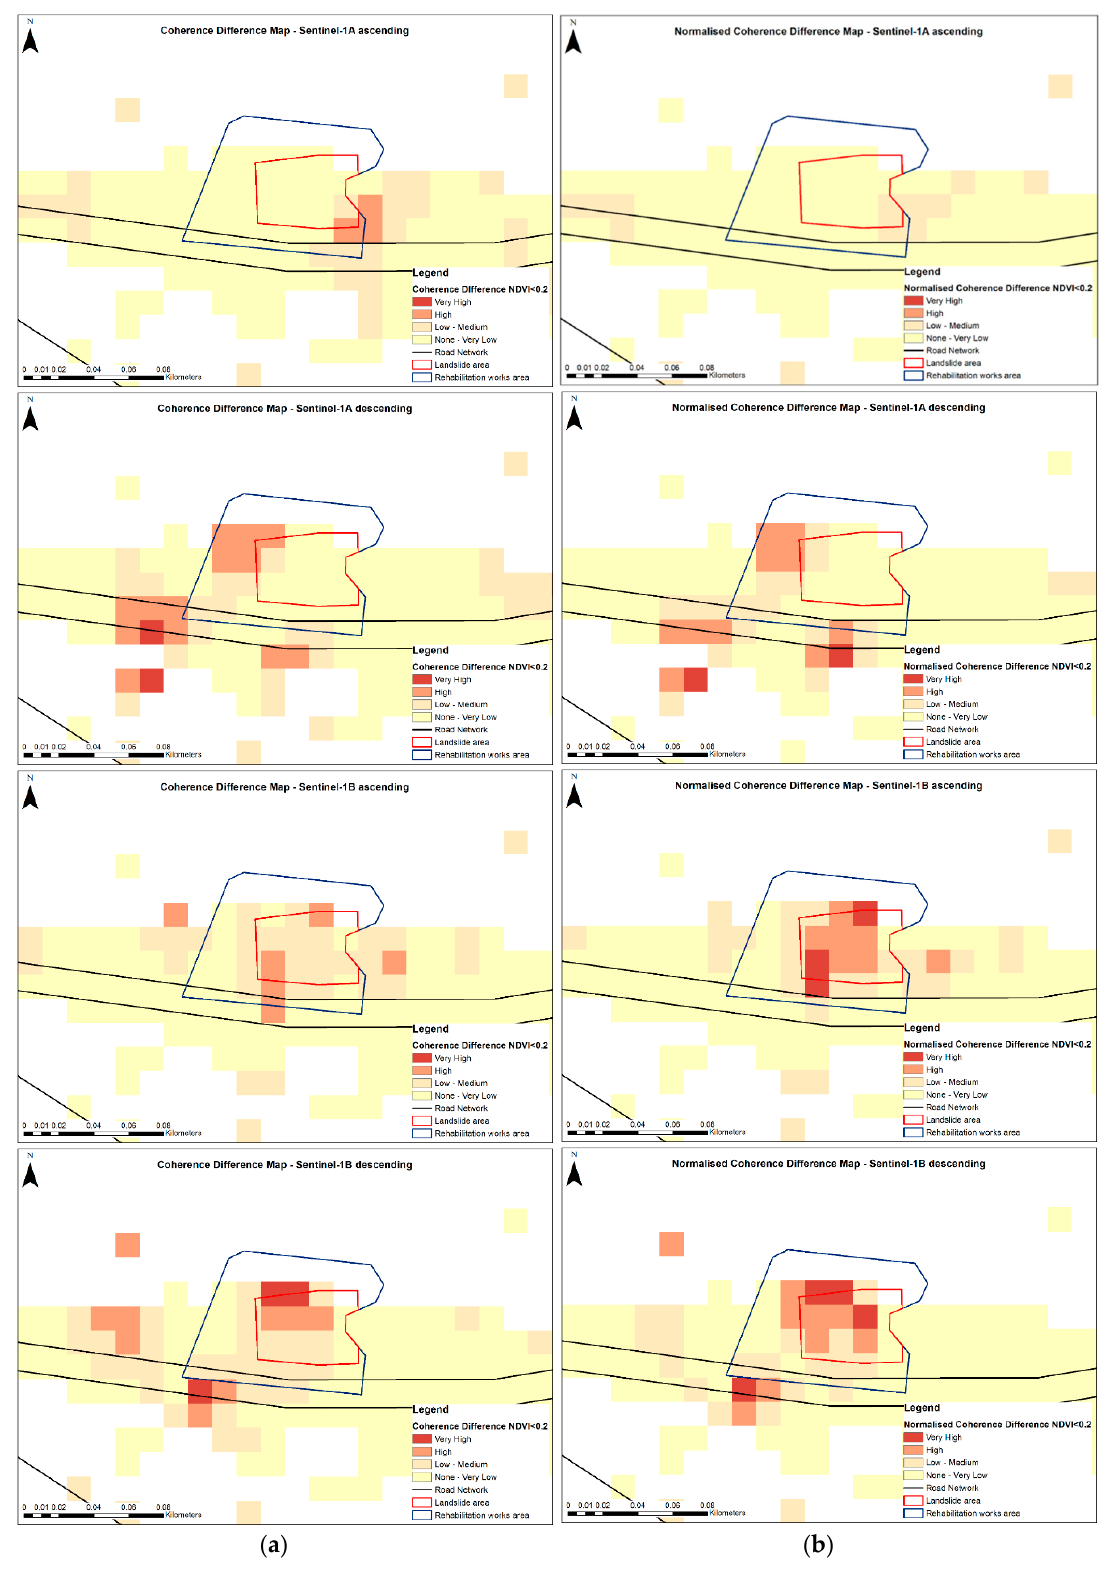
Figure 19. ( a ) Coherence di ff erence and ( b ) normalized coherence di ff erence maps—Sentinel-1A ascending (first), Sentinel 1-A descending (second), Sentinel 1-B ascending (third), and Sentinel 1-B descending